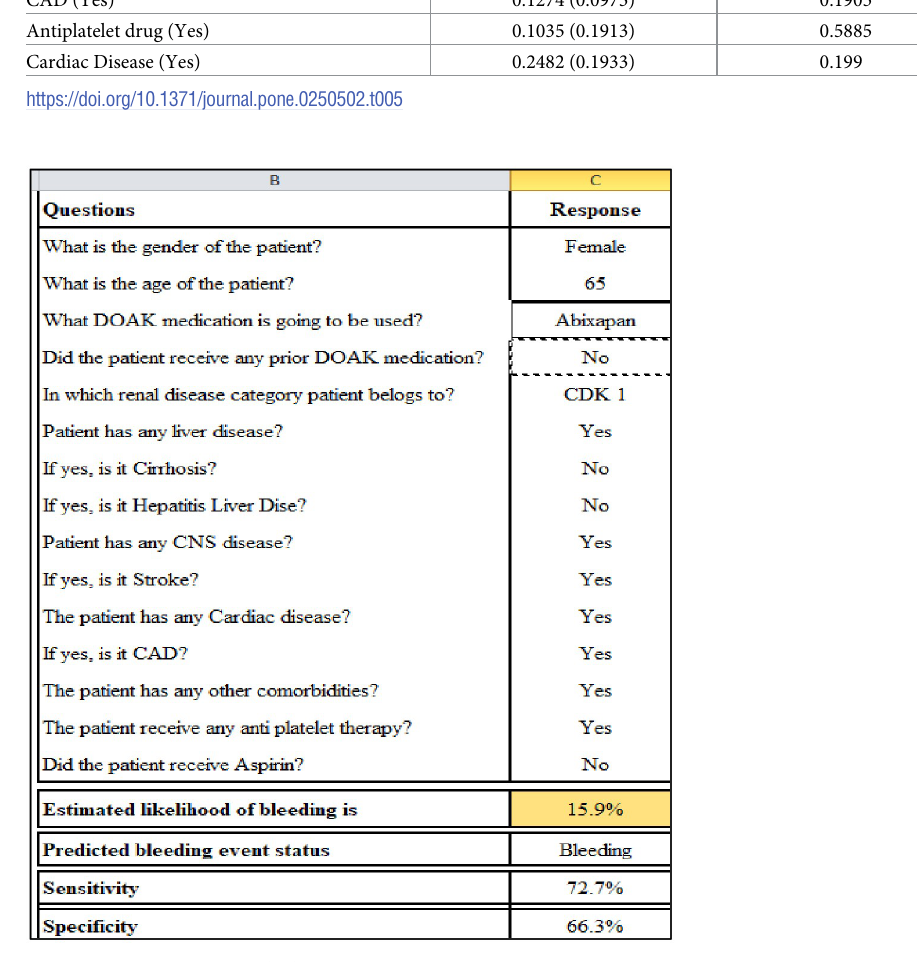
Fig 3. GAMA RL STC score